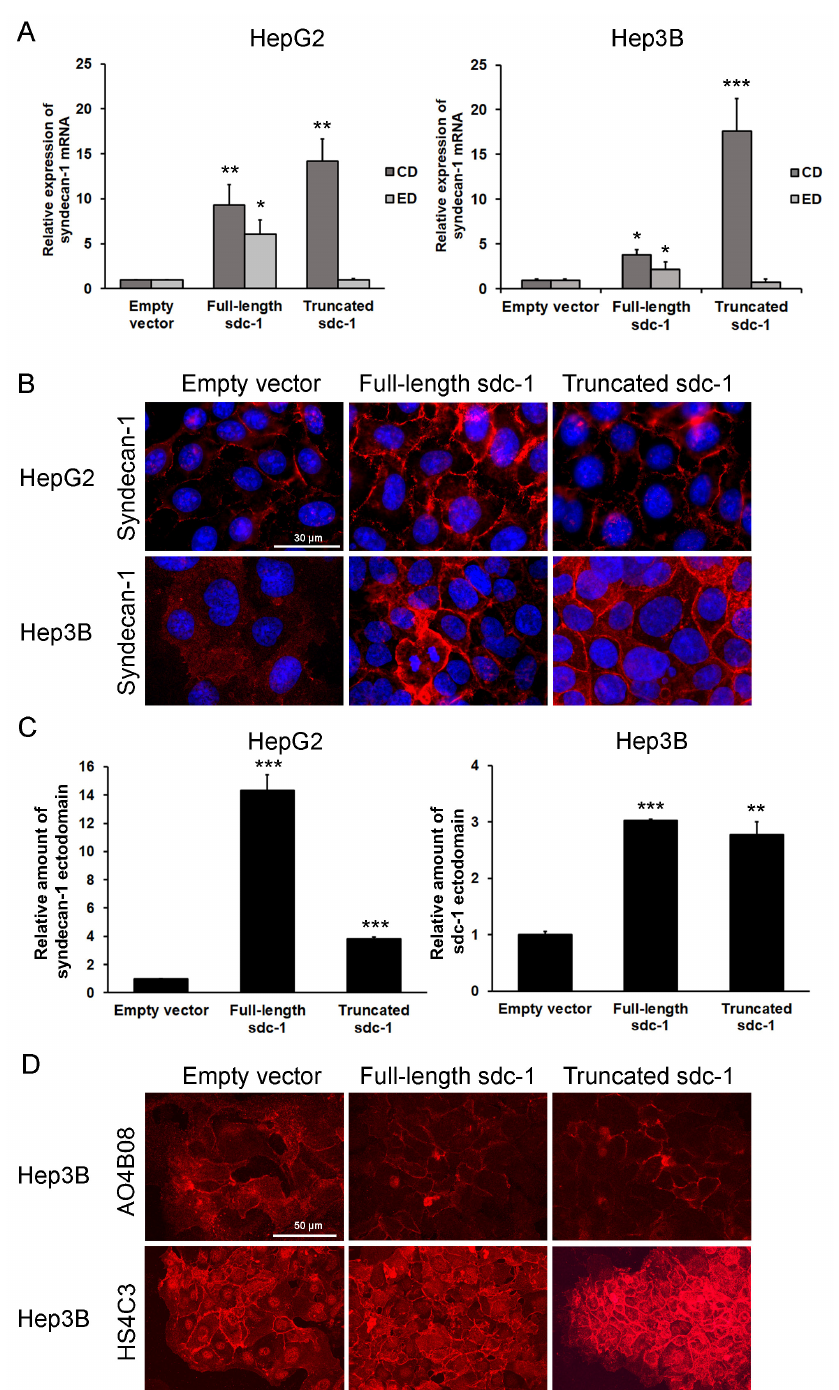
Figure 3. Syndecan-1 mRNA and protein levels in the empty vector and syndecan-1 transfected HepG2 and Hep3B cell lines. ( A ) Transcripts coding for the extracellular domain (ED) and the cytoplasmic domain (CD) of syndecan-1 were elevated in the full-length transfectants, while the expression of the CD only was increased in the truncated transfectants, whereas that of the ectodomain-coding transcript remained unchanged; ( B ) High amounts of full-length (ectodomain-containing) syndecan-1 protein were detected on the surface of both full-length and truncated syndecan-1 transfectants by immunofluorescence using an ectodomain-specific antibody; ( C ) ELISA confirmed elevation of full-length syndecan-1 in both transfectants; ( D ) A comparison with the empty vector-transfected cells, shows that the abundance of AO4B08-reactive (internal 2- O -sulfated / 6- O -sulfated) HS epitopes are decreased, whereas the amount of HS4C3-reactive (highly sulfated, 3- O -sulfated) epitopes are increased in both Hep3B cell lines containing syndecan-1 constructs. Data points represent the mean ± standard deviation (SD), n = 3; * p < 0.05; ** p < 0.01; *** p < 0.001 versus the empty vector control. Representative images are at 600 × magnification (scale bar 30 µ m) and 400 × magnification (scale bar 50 µ